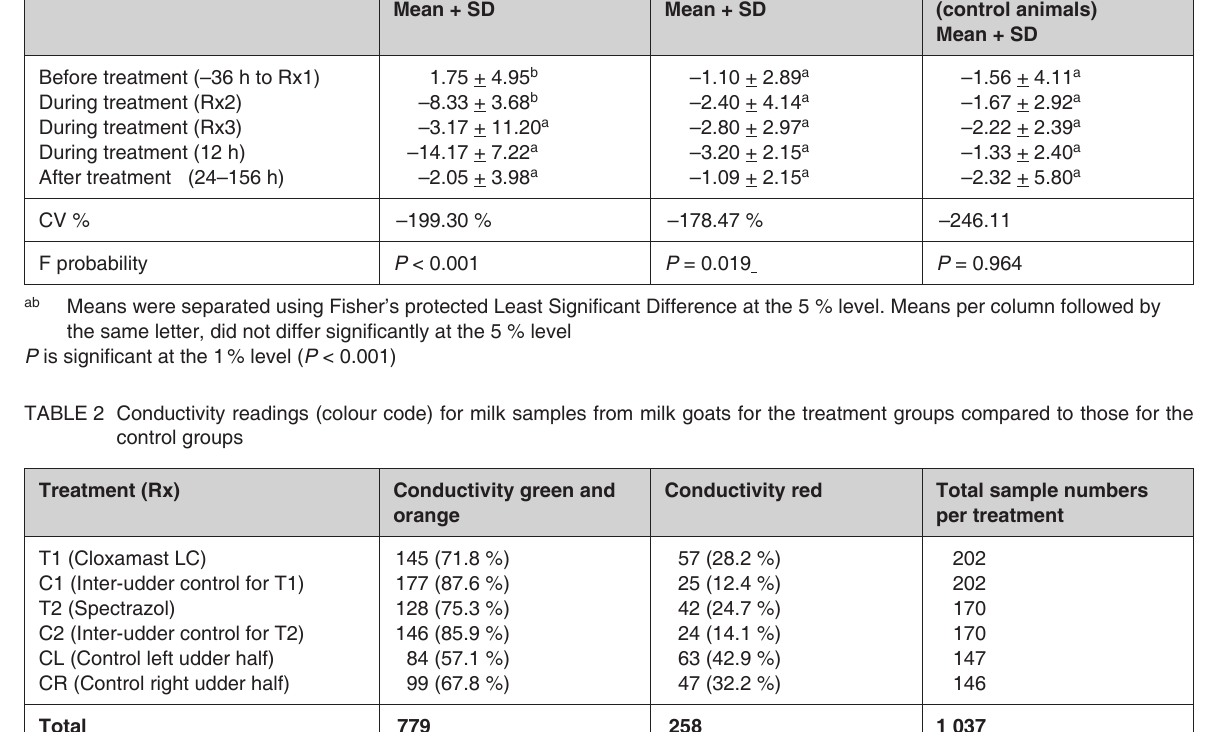
TABLE 1 Conductivity scores for treated and untreated udder halves of milk goats, before, during and after treatment with Cloxamast (T1) and Spectrazol (T2) compared to those of the control animals (both halves not treated) Treatment time (Rx)